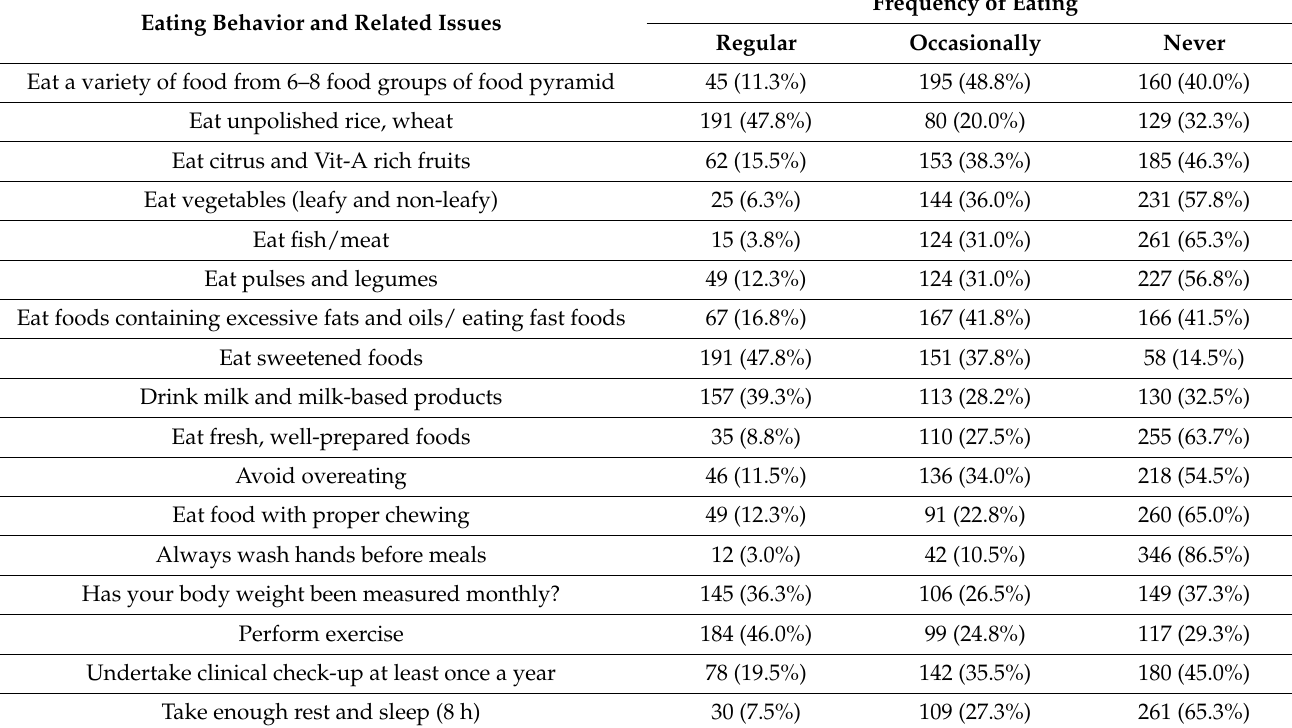
Table 2. Assessment of healthy eating behaviors among study participants (N = 400).